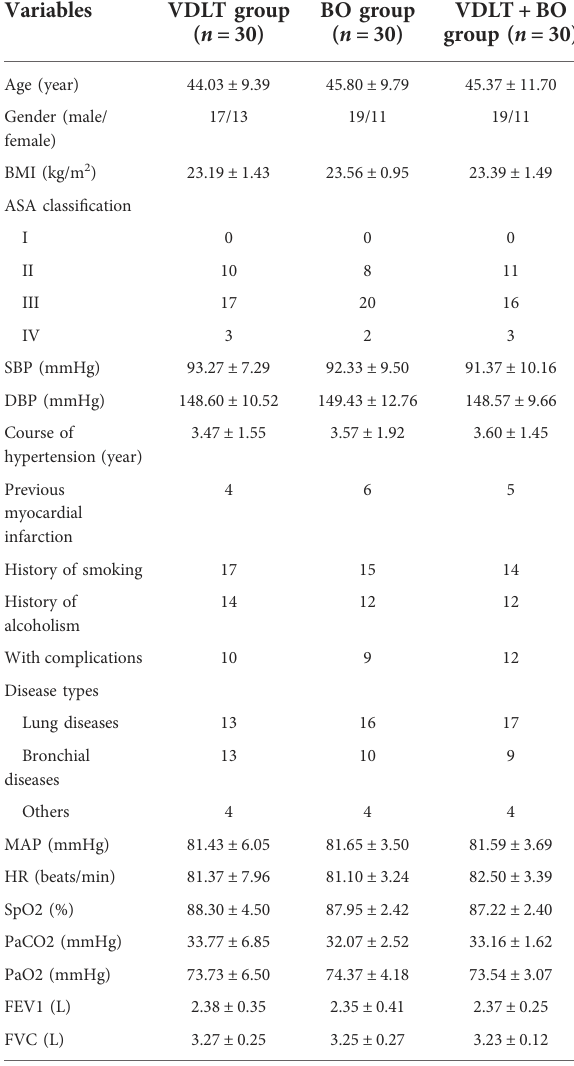
TABLE 1 Comparison of baseline characteristics of included